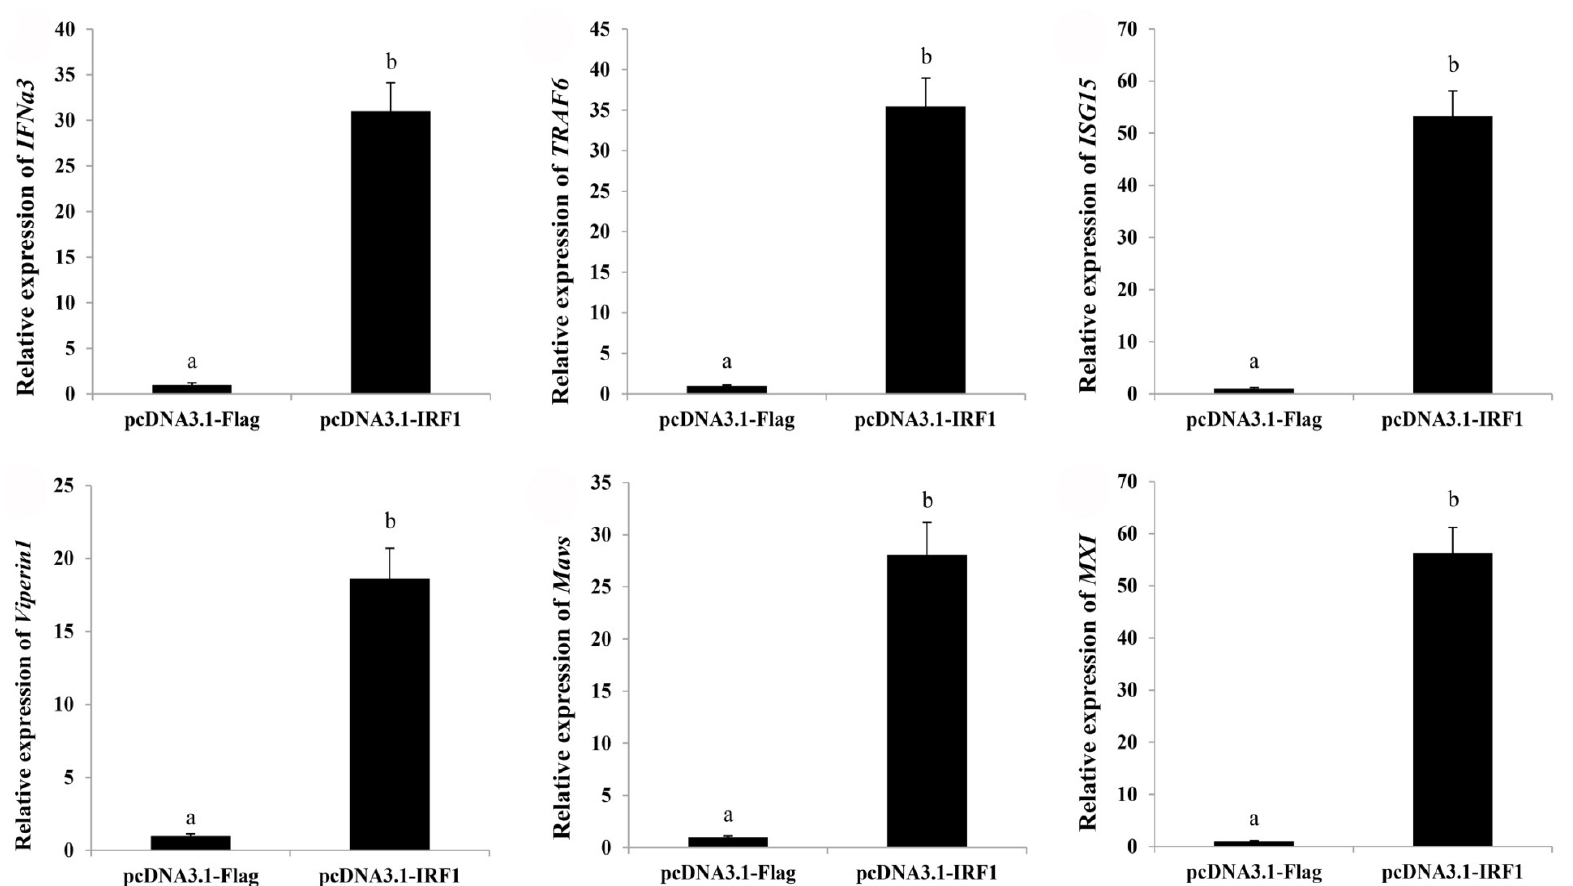
Figure 6. Overexpression of ToIRF1 altered the expression levels of interferon signaling molecules in GPS cells for 36 h. The expression levels of interferon signaling molecules, including IFNa3 , TRAF6 , ISG15 , Viperin1 , Viperin2 , Mavs , and MXI, were examined using qRT-PCR analysis. The EF-1 α gene was employed as an internal control. The messenger RNA (mRNA) expression level in GPS cells transfected with an empty vector was set as one-fold. Di ff erent letters indicate significant di ff erences ( p < 0.05).